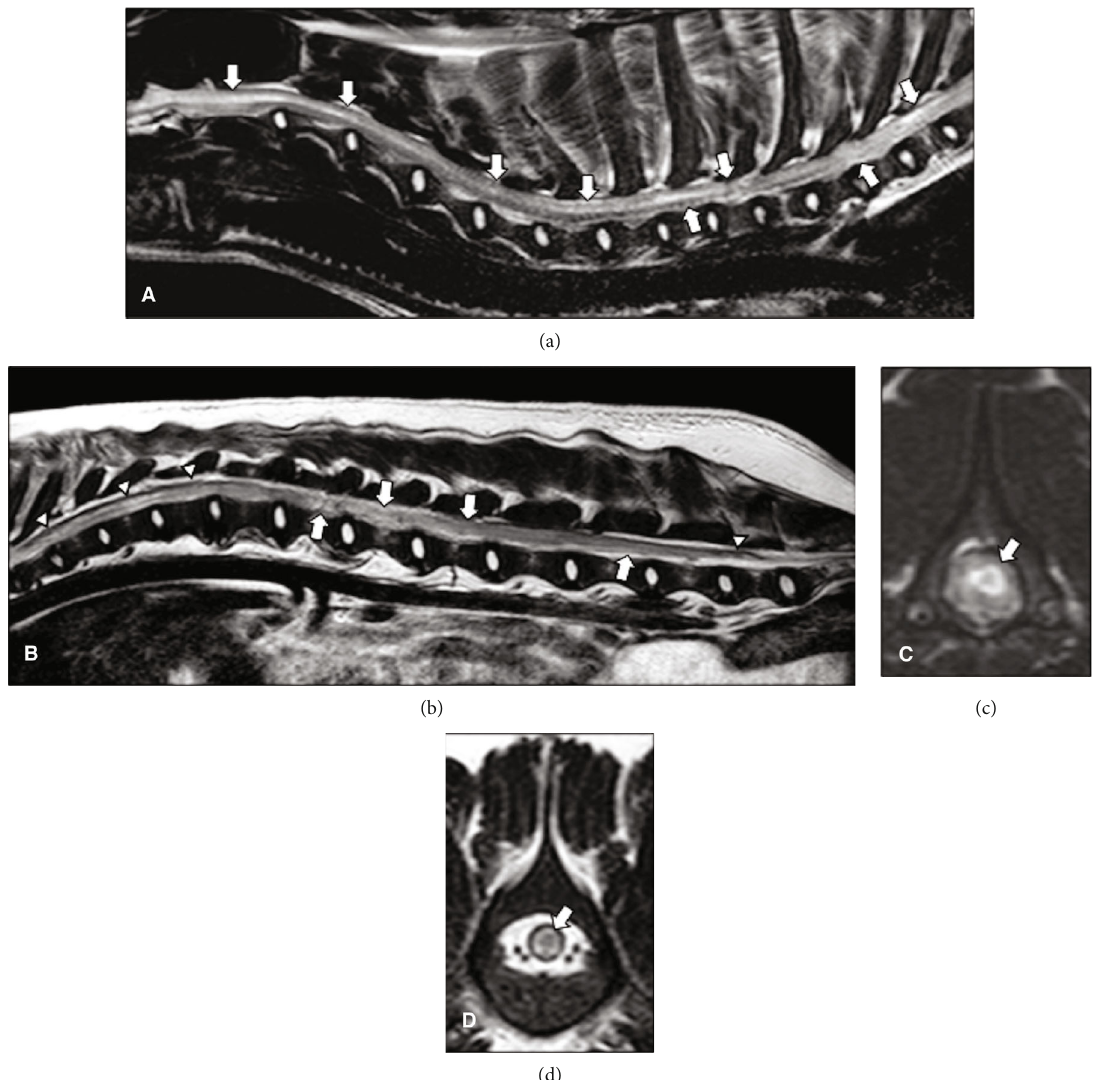
Figure 1: MRI T2-weighted sagittal planes (a, b) of the cervical, thoracic, and lumbar vertebral column showing an extensive heterogeneous intramedullary lesion (arrows) and the presence of a hypointense dorsal rim suggesting subdural haematoma (small arrows on (b)). On the transverse planes at the level of C2 (c) and L5 (d), there are similar isointense lesions surrounded by a hyperintense rim (arrows). These signal patterns are consistent with a haematomyelia changing from early subacute to late subacute with intra- and extracellular